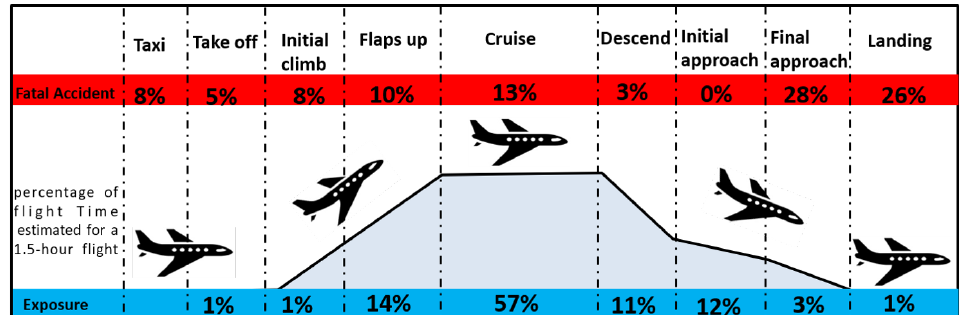
Figure 1. Percentage of fatal accidents and onboard fatalities—2010–2020.